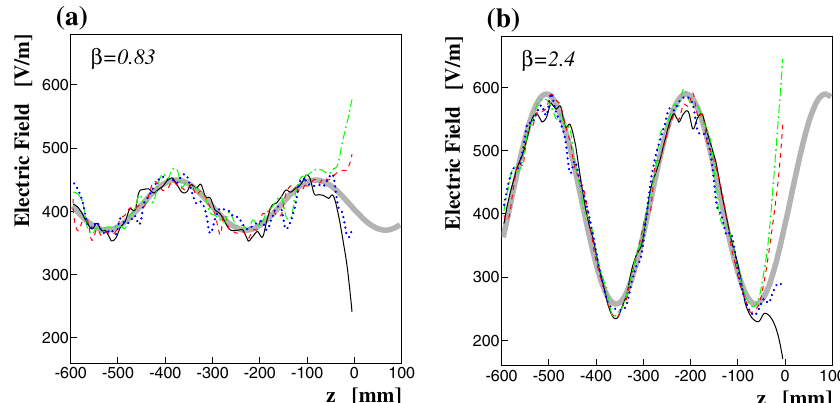
FIG. 2. (Color) Standing-wave patterns of the electric field in the ARES coupler coaxial line at the resonance frequency for the coupling coefficient ( (cid:4) ) values of (a) 0.83 and (b) 2.4, where the z region is extended to z (cid:4) (cid:3) 600 mm , obtained using a three- dimensional electromagnetic simulation. The finer solid, dashed, dash-dotted, and dotted lines indicate the patterns at (cid:1) (cid:4) 27 (cid:8) , 117 (cid:8) , 207 (cid:8) , and 297 (cid:8) , respectively, and r (cid:4) 27 : 6 mm , where the coupling loop of the input coupler is set at (cid:1) (cid:4) 27 (cid:8) , simulating the ARES cavity with the multipactoring problem explained in Sec. I. There are some fine noisy structures due to the finite mesh sizes in the simulation. The gray bold lines are fit results using a sinusoidal function for the average of the four patterns in the region of (cid:3) 600 mm < z < (cid:3) 50 mm . The field strengths are normalized to the time-averaged input rf power of 1 W